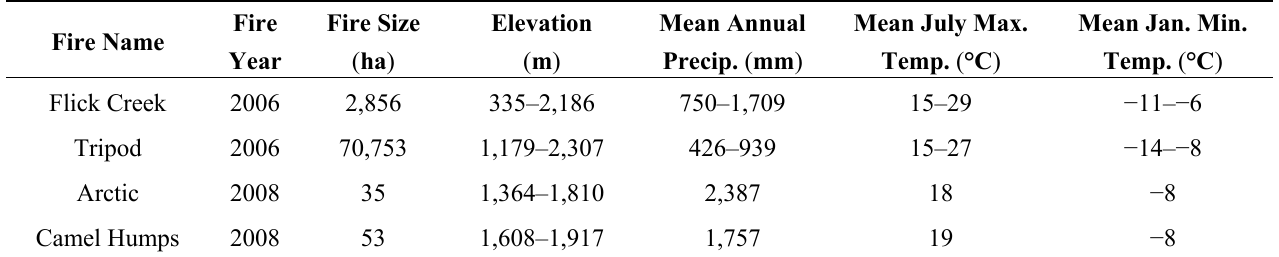
Table 2. Characteristics of locations burned by fires included in study. Precipitation and temperature are 1971 to 2000 averages. Ranges are given for the large fires and reflect spatial variation in gridded climate data within the fire [39–41].